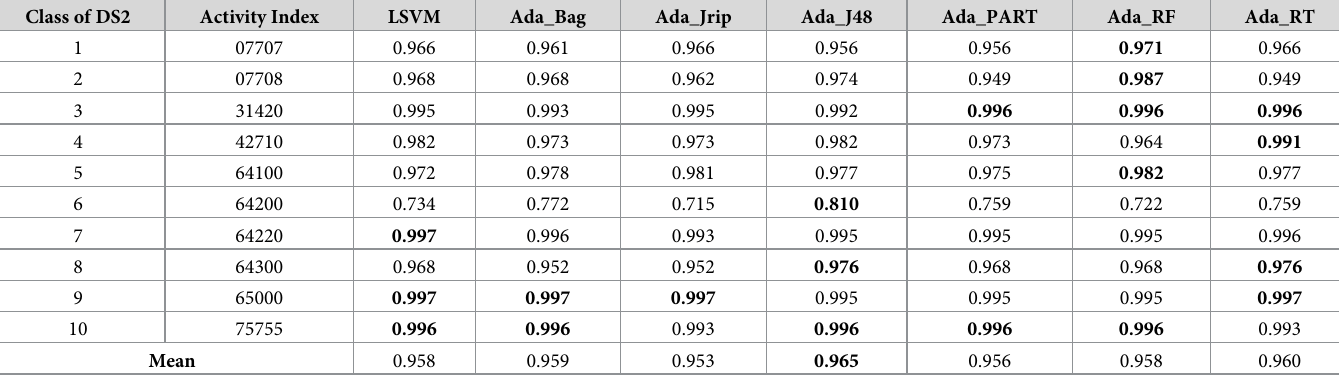
Table 5. Sensitivity measure for the prediction of new bioactive molecules with DS2 (homogeneous). Class of DS2